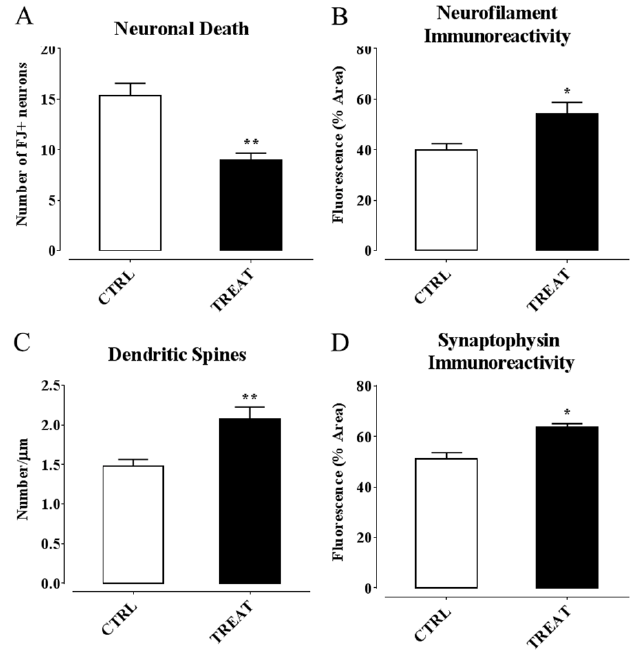
Figure 3. Effect of α -tocopherol treatment on hippocampal neurodegeneration induced by status epilepticus. ( A ) Degenerating neurons quantified as FluorJade-positive cells along rostro-caudal extension of CA1 field; ( B ) Neurofilament immunoreactivity expressed as percent of area fluorescence; ( C ) Dendritic spine number quantified per unit length of dendrite; ( D ) Synaptophysin immunoreactivity expressed as percent of area fluorescence. Statistical analyses performed by ( A ) Student’s t test: ** p < 0.01 and ( B – D ) one-way ANOVA and Tukey’s post hoc test: * p < 0.05; ** p < 0.01. Figure modified from [276].